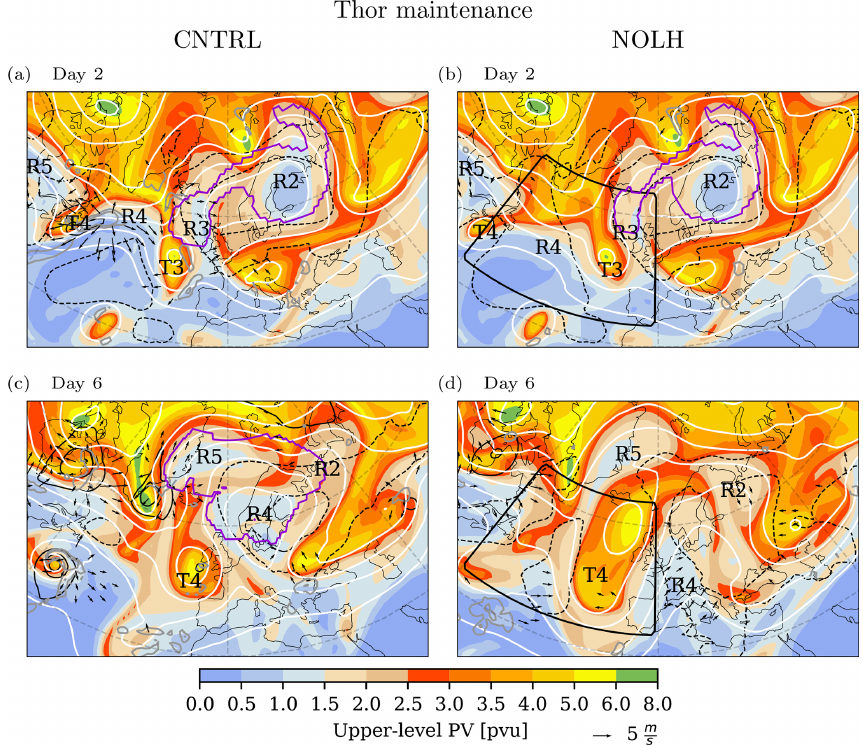
Figure 4. Same as Fig. 3, but at (a, b) 09:00UTC 11 October 2016 (day 2) and (c, d) 09:00UTC 16 October 2016 (day